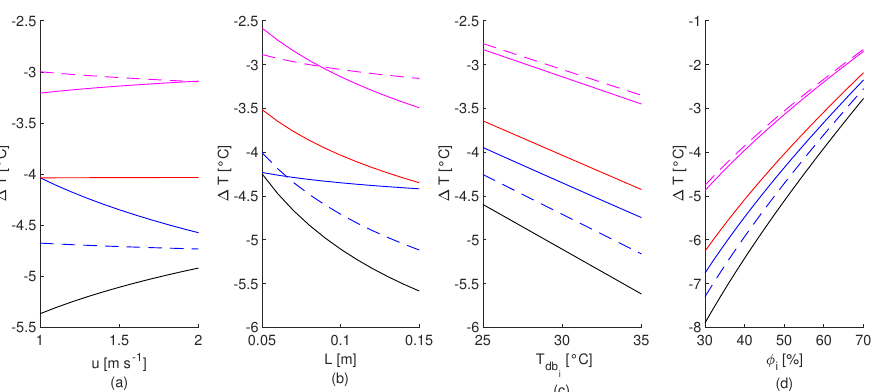
Figure 7. Comparison of inlet-outlet air dry-bulb temperature change ( ∆ T ) of each pad material analysed. ( a ) As function of inlet air velocity ( u ). ( b ) As function of pad thickness ( L ). ( c ) As function of dry-bulb temperature of inlet air ( T db ). ( d ) As function of relative humidity of inlet air ( φ i ). For i each plot the other parameters remained constants: u = 1.5 m s − 1 , L = 0.1 m, T db = 30 ◦ C and φ i = 60%. i CL : solid black line; CS 1 : blue solid line; CS 2 : blue dashed line; BC : red solid line; PS 1 : magenta solid line; PS 2 : magenta dashed line.